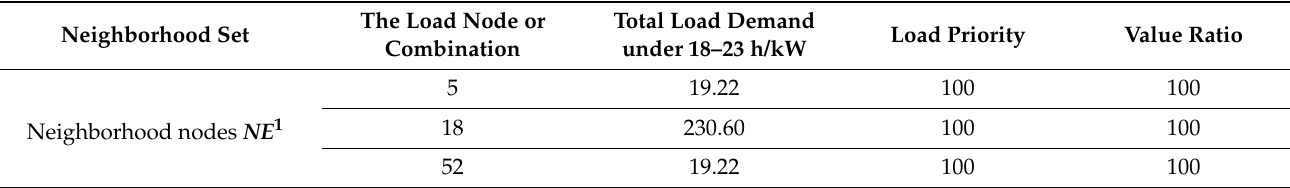
Table 2. The value ratio from the first searching